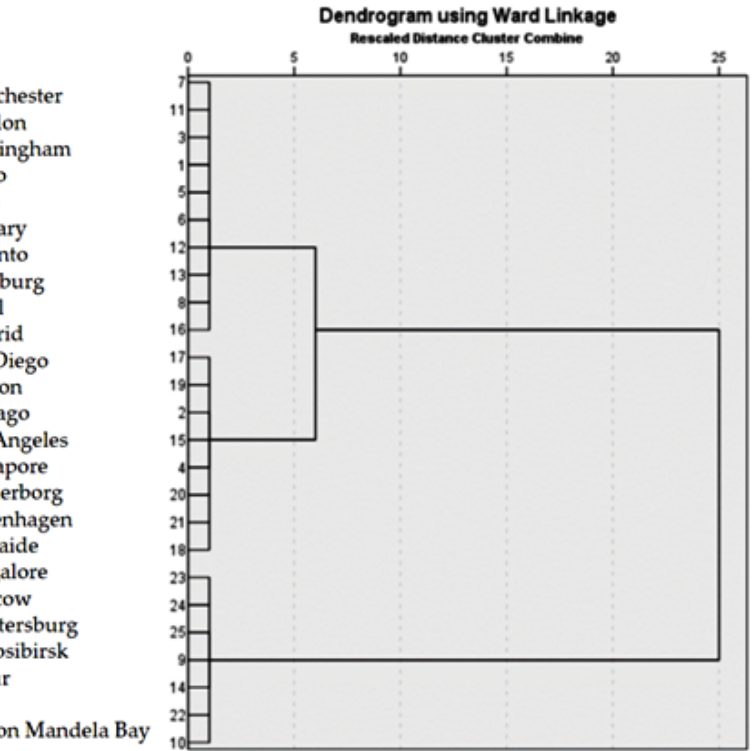
Figure 2. Dendrogram using Ward’s method, compiled by the authors.